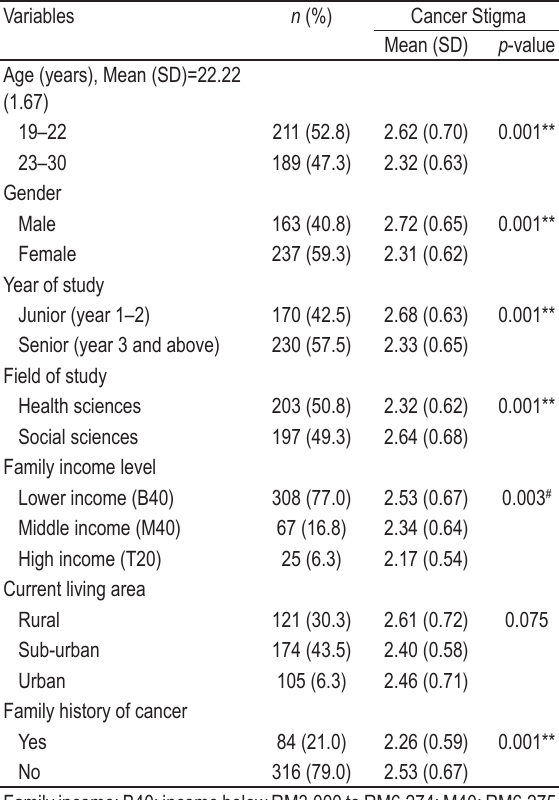
TABLE 1. The sociodemographic variables and cancer stigma ( n =400)